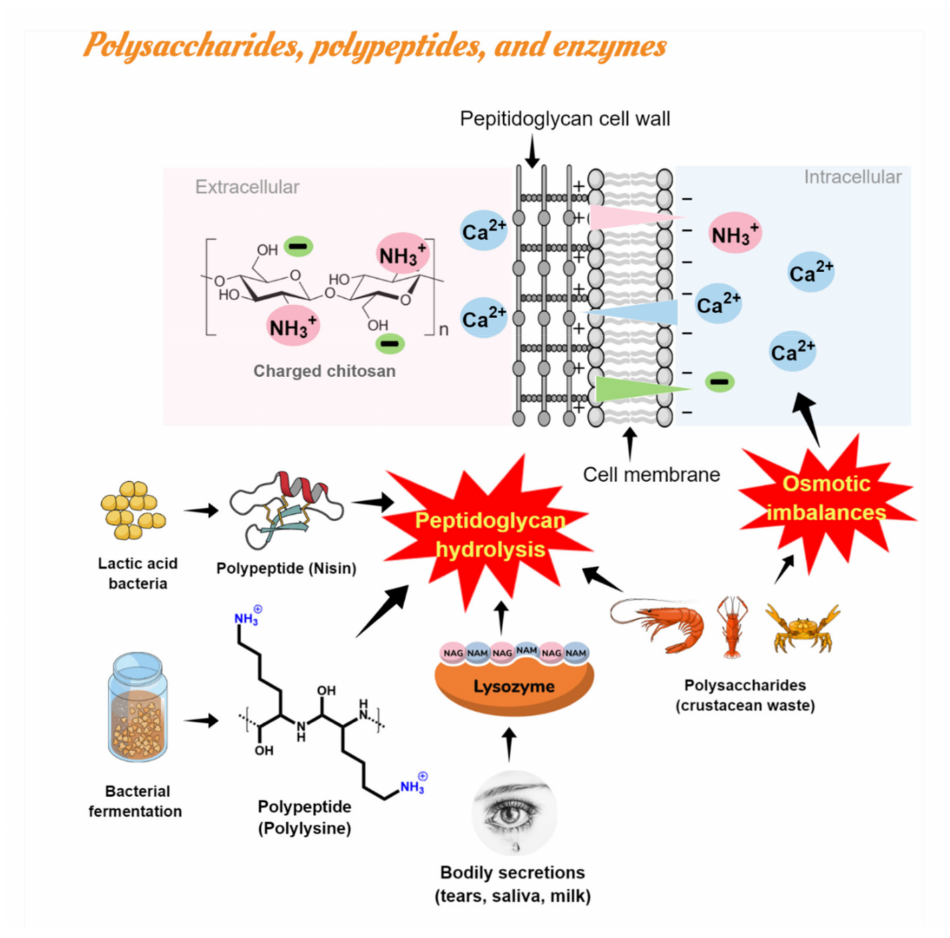
Figure 4. Antimicrobial action of polysaccharides, polypeptides, and lysozyme: membrane per- meability alteration and hydrolysis of peptidoglycans in the microbial cell wall by electrostatic